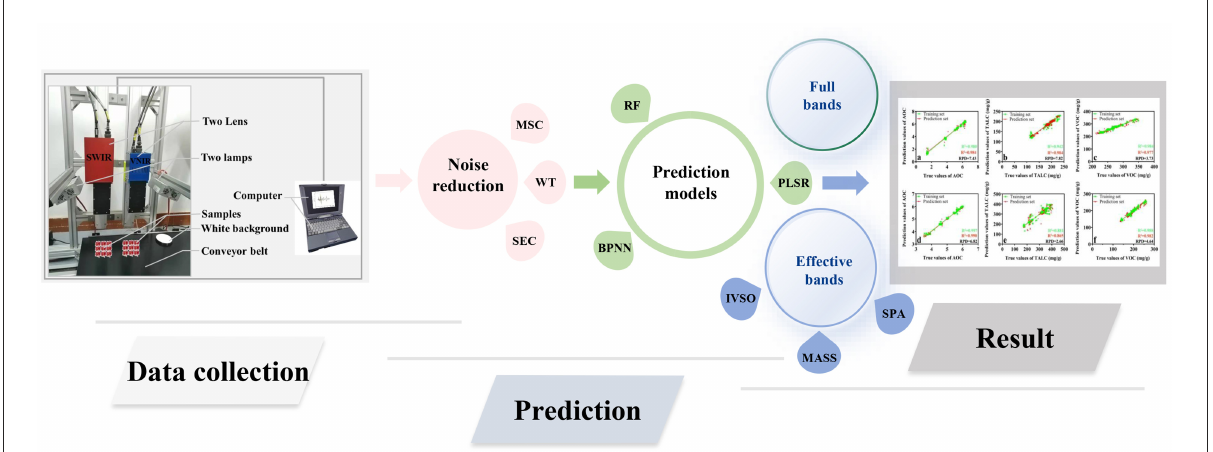
FIGURE1 Schematic overview of the analytical flowchart. Three noise reduction methods including multiplicative signal correction (MSC), second derivative (SEC), and wavelet transform (WT). Three prediction models including back-propagation neural network (BPNN), partial least square regression (PLSR), and random forest (RF). Three effective bands selection methods including iteratively variable subset optimization (IVSO), model adaptive space shrinkage (MASS), and successive projections algorithm